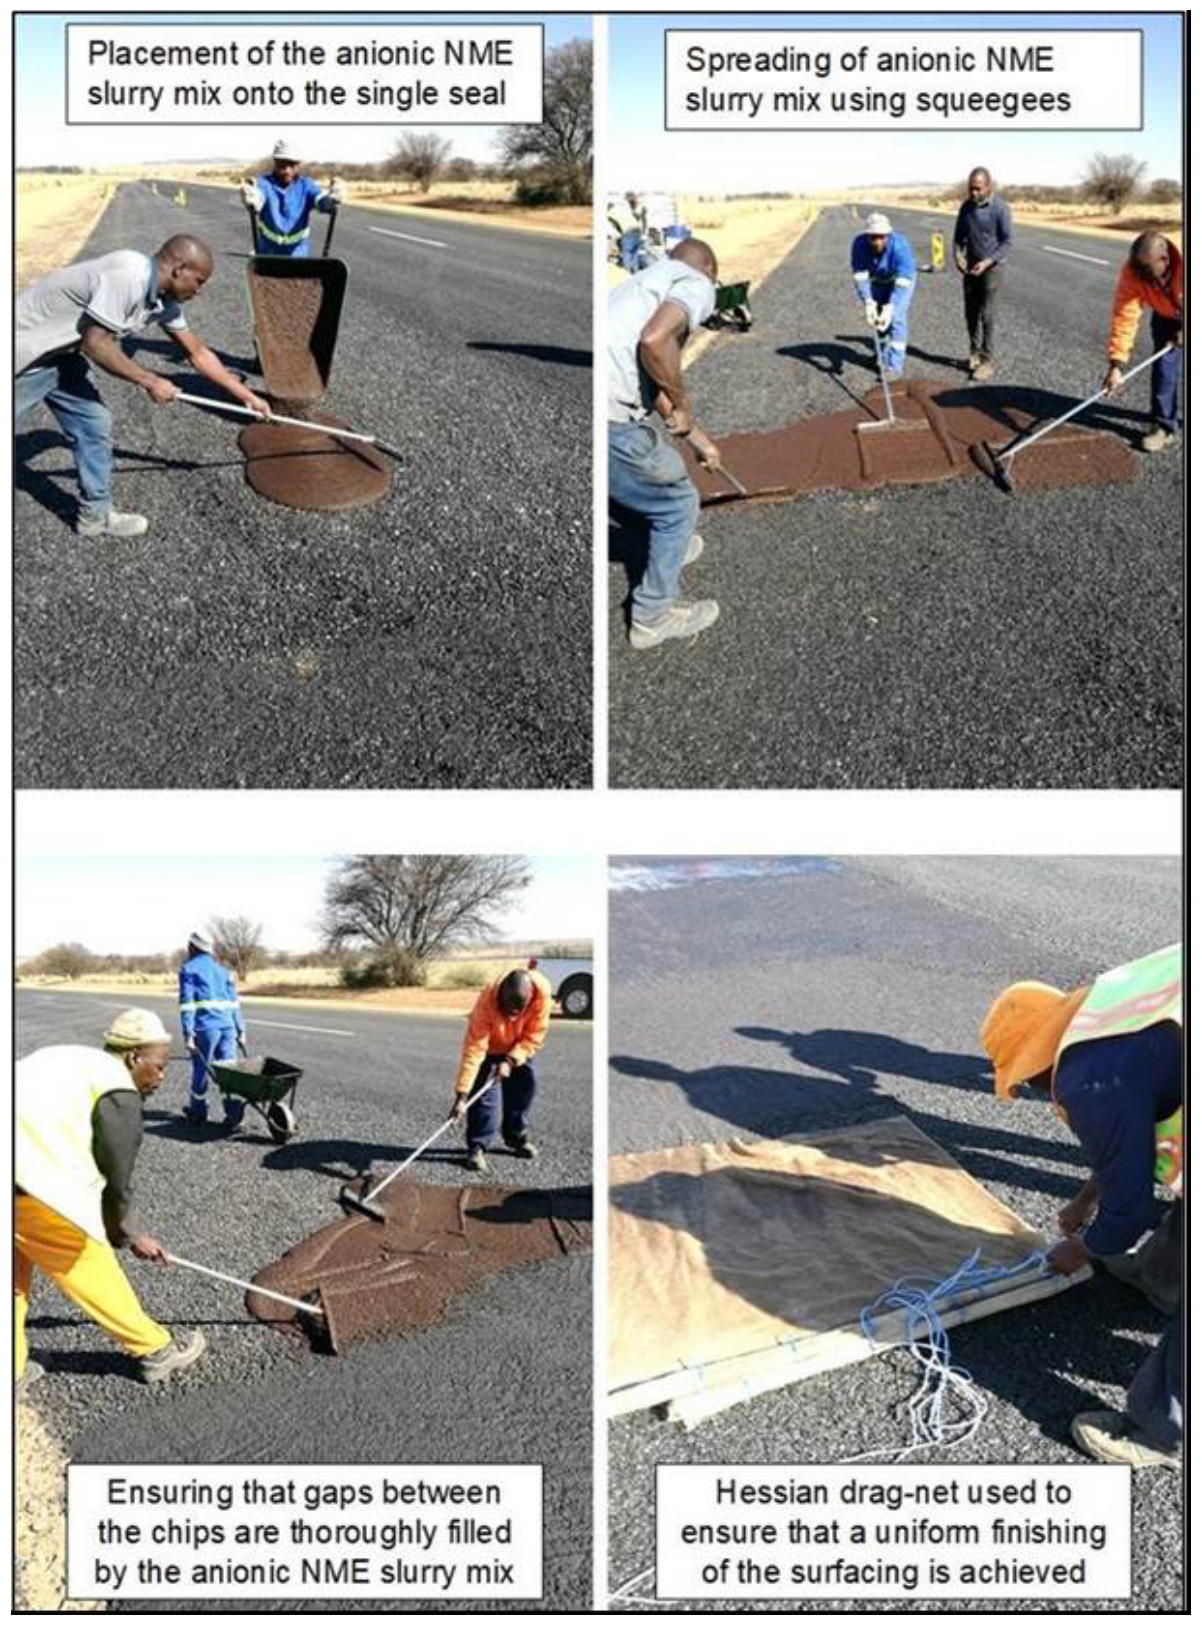
Figure 20. Labour-intensive construction of a modified cape seal using an anionic NME binder with the slurry mixed on site next to the road.